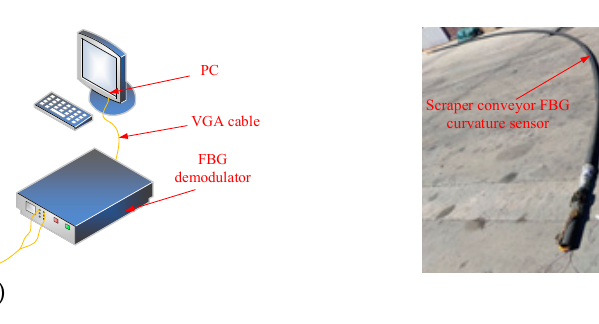
Figure 8. Curvature rotation error angle test system of FBG curvature sensor of scraper conveyor. ( a ) Experimental schematic diagram; ( b ) photo of experiment process.